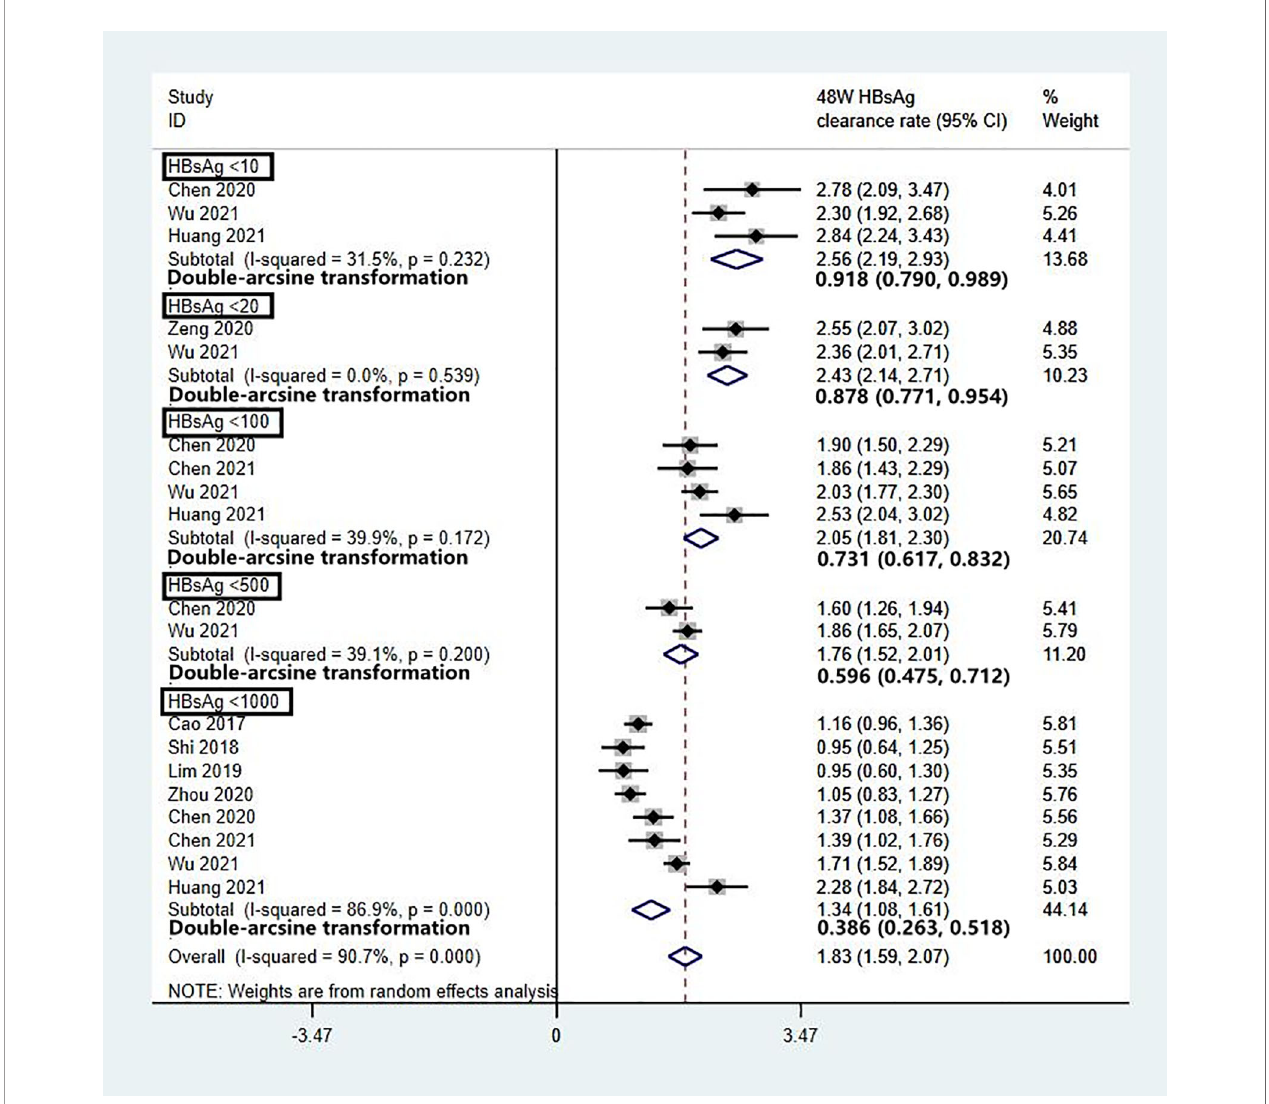
FIGURE 5 | Subgroup analysis of the 48-W HBsAg clearance rate among different baseline